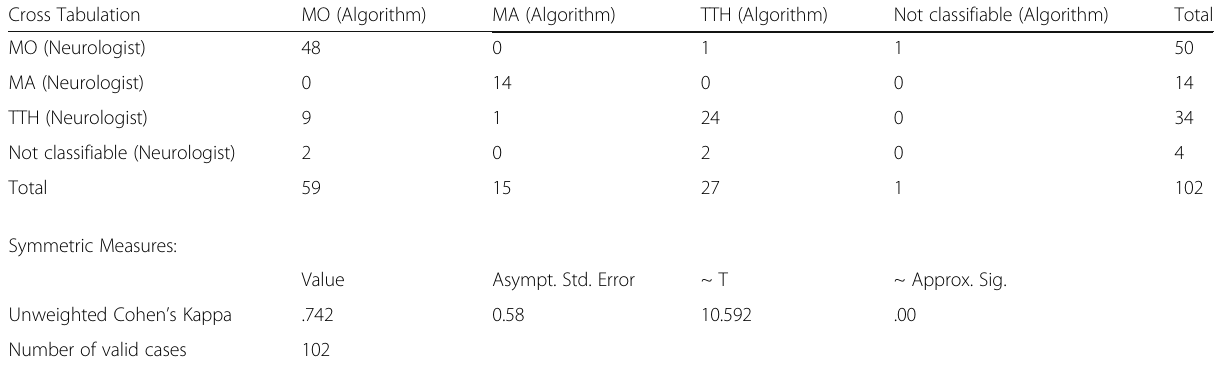
Table 1 Cross-tabulation results and level of agreement between neurologist and algorithm Cross